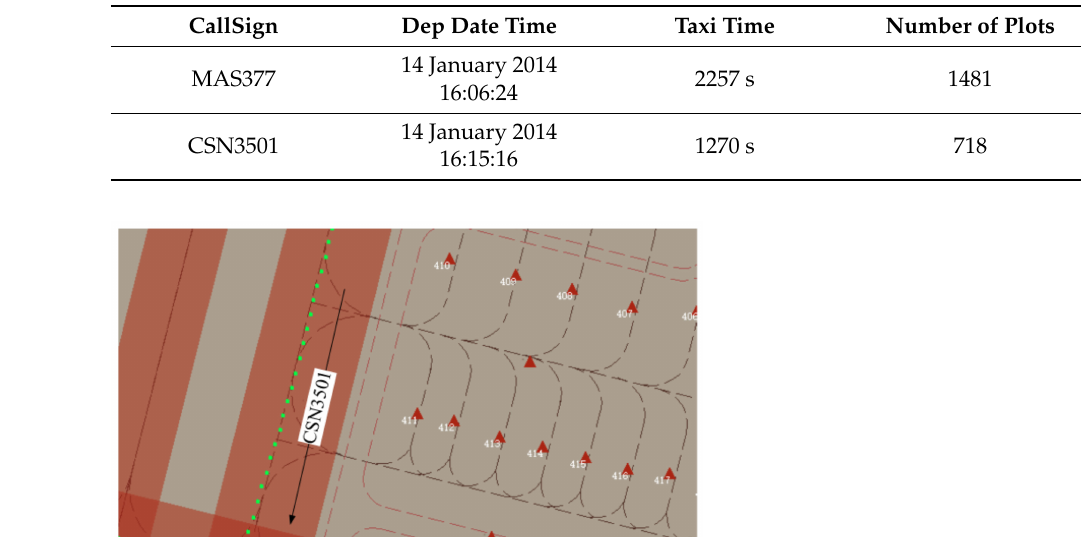
Table 1. Trajectory data information.